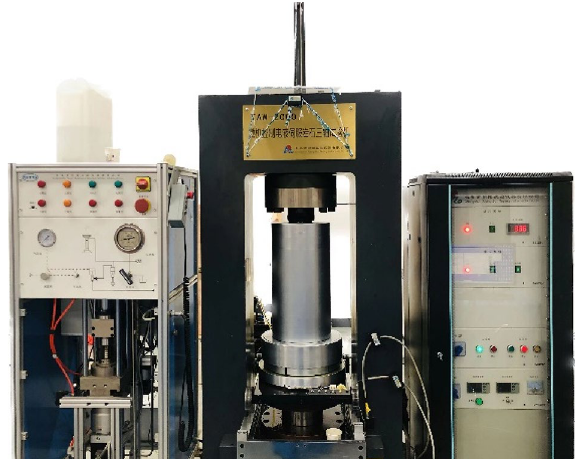
Figure 6. Test equipment TAW2000.